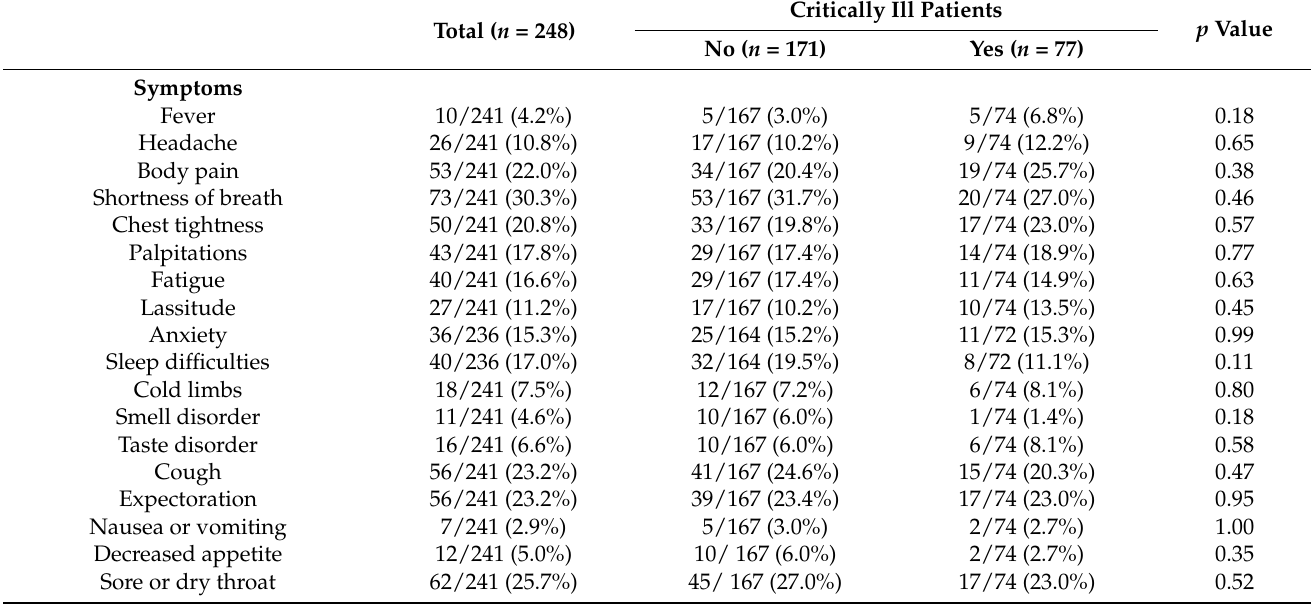
Table 2. Symptoms and chest CT results of follow-up according to severity